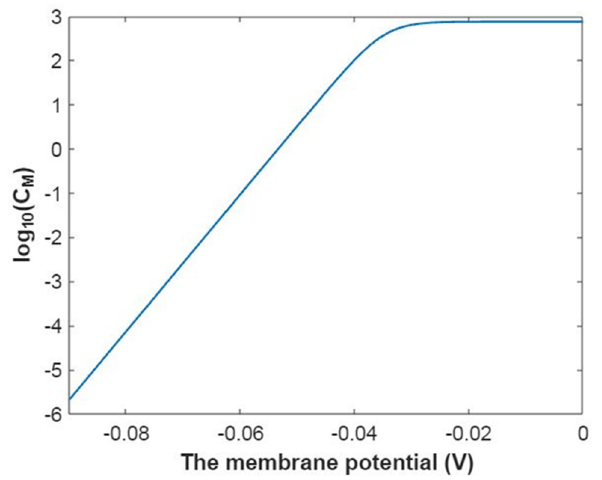
Figure 19. The relationship between membrane potential and the common logarithm of the mem- brane conductance of potassium ions according to the Boltzmann distribution at G = − 5.35 J and over a membrane potential range from − 0.09 V to 0 V. The membrane conductance of potassium ions at membrane potential − 0.087